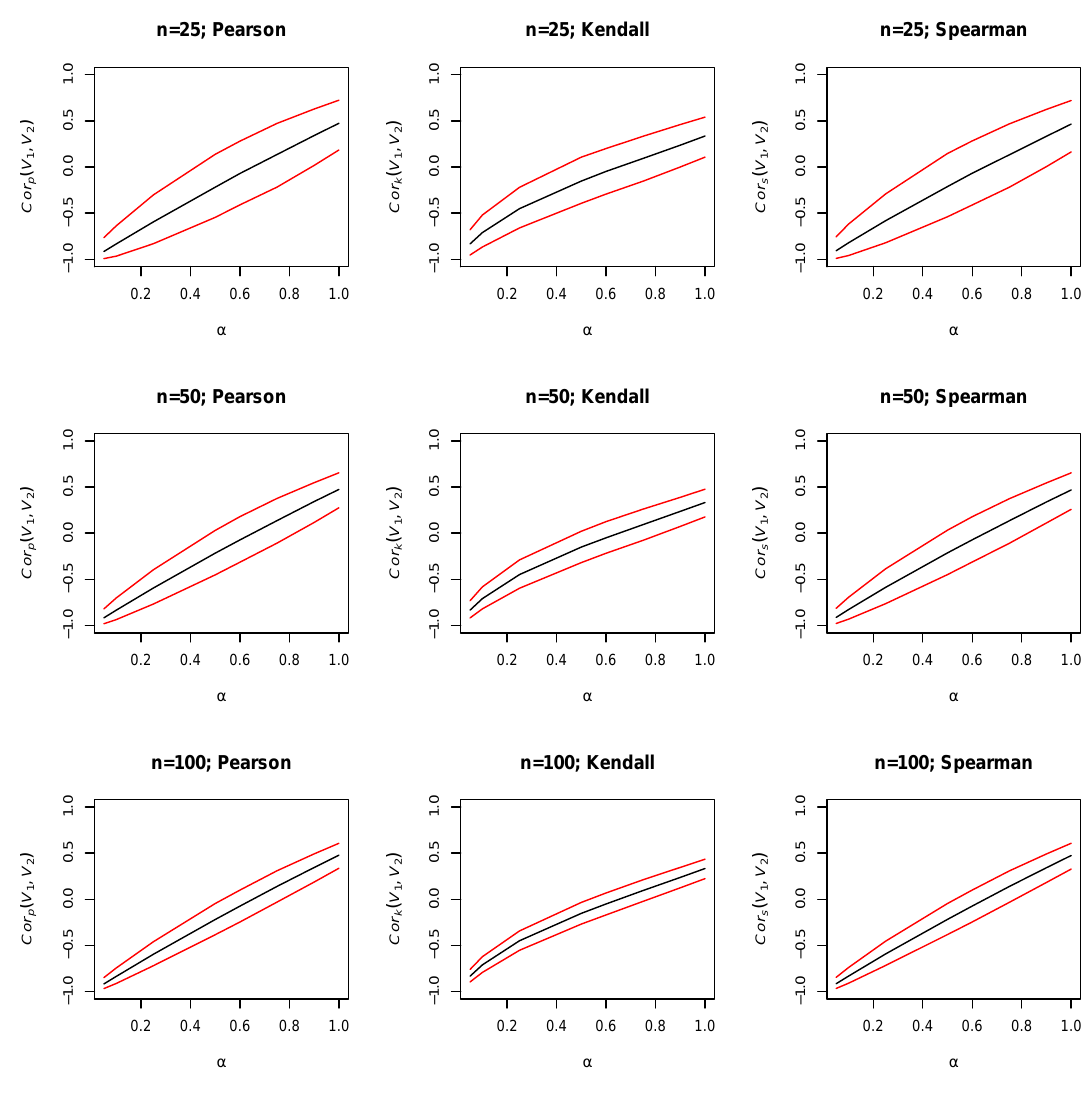
Figure 3: AN(5A) correlations, Pearson, Kendall’s Tau, and Spearman, as a function of α , with 95% confidence bounds, obtained from